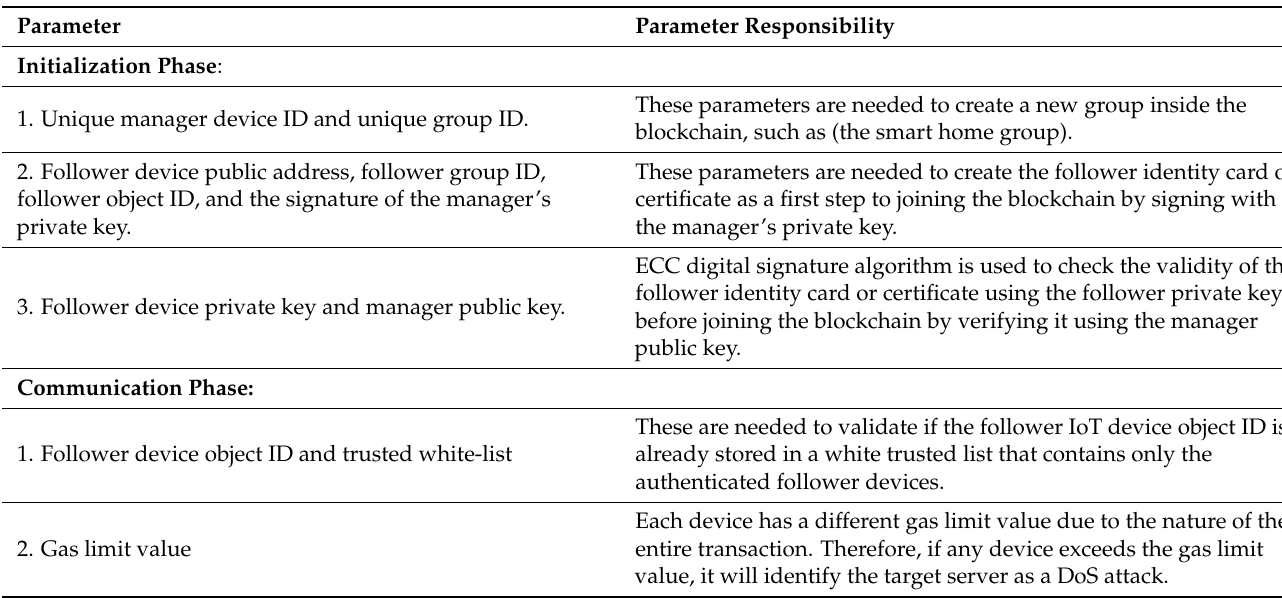
Table 3. The selective parameters of the modeling and simulation